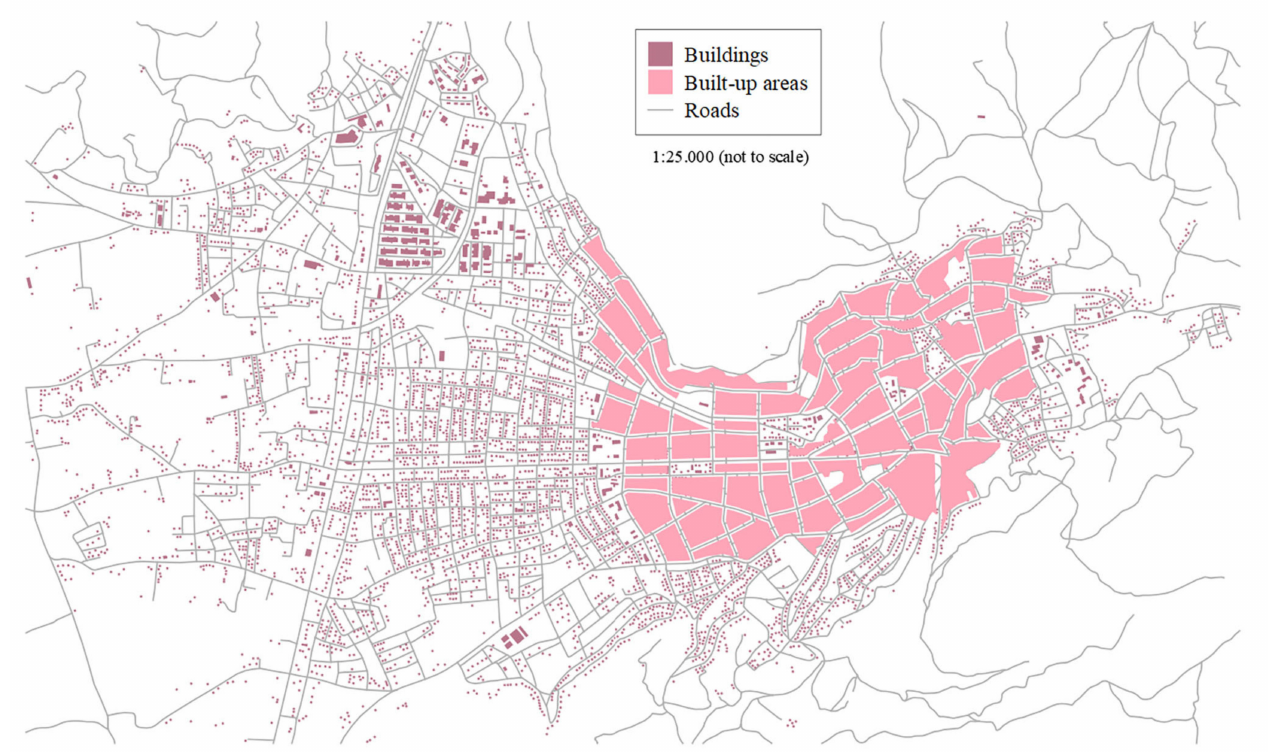
Figure A1. 1:25k topographic map data of the study